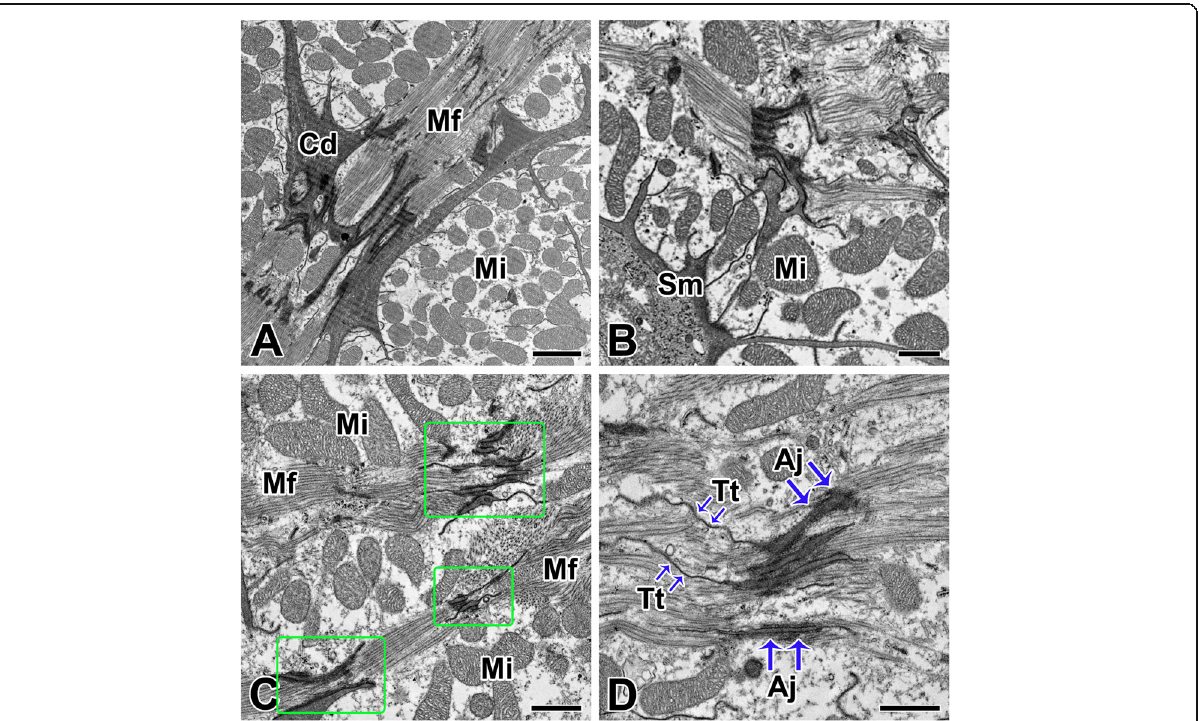
Fig. 3 Transmission electron micrographs of the intercalated disc in the spider, L. mactans. a : Intercalated discs (Cd) run perpendicular to the direction of the myofibrils (Mf) dividing adjacent cardiac muscle cells. b : Well-developed mitochondria (Mi) are located very close to the intercalated disc. c : Intercalated discs contain gap junctions and desmosomes (rectangles) at the junctional area between muscle fibers. d : In cross section, isolated polygonal tubules representing the site of the gap junction, and adherens junction (Aj) appeared. Tt: T-tubule. Scale bars indicate 2 μ m (A) and 1 μ m (B-D),